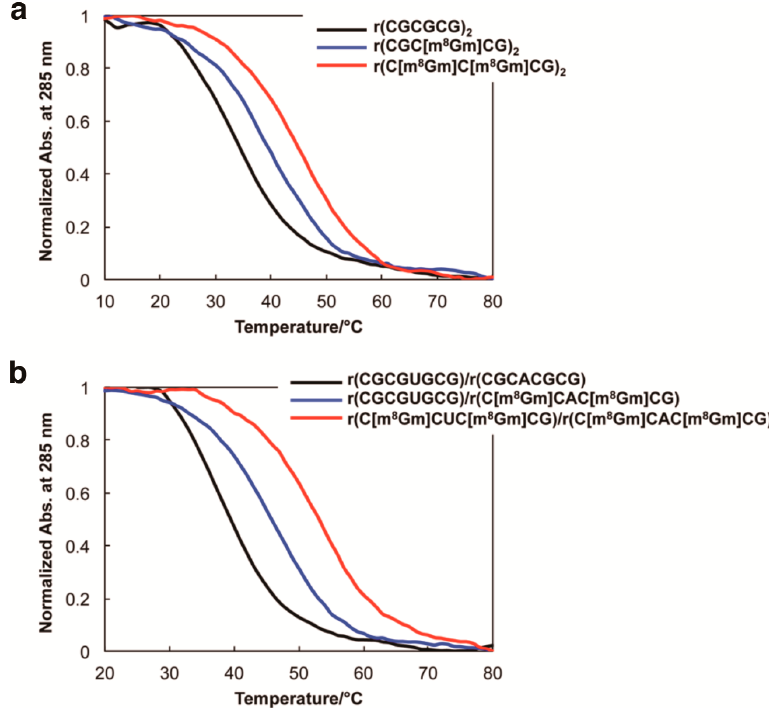
Figure 2. ( a ) CD melting curves for native RNA r(CGCGCG) 2 (back line), r(CGC[m 8 Gm]CG) 2 containing one m 8 Gm (blue line), and r(C[m 8 Gm]C[m 8 Gm]CG) 2 containing two m 8 Gms (red line). ( b ) CD melting curves for RNA sequences containing an AU base pair, native RNA r(CGCGUGCG)/r(CGCACGCG) (back line), r(CGCGUGCG)/r(C[m 8 Gm]CAC[m 8 Gm]CG) having two m 8 Gms in one strand (blue line), r(C[m 8 Gm]CGU[m 8 Gm]CG)r(C[m 8 Gm]CAC[m 8 Gm]CG) having four m 8 Gms in two strands (red line). In 5 mM sodium phosphate buffer (pH 7.0), 7 M NaClO 4 concentrations (0.15 mM base concentration).